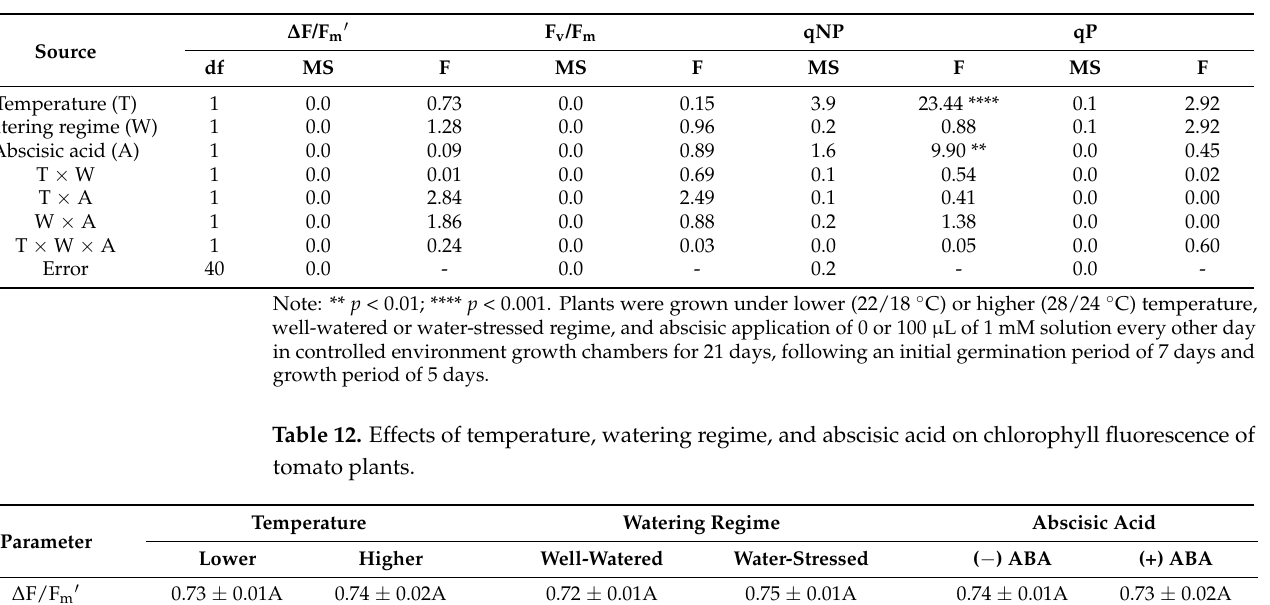
Table 11. Analysis of variance for effects of temperature, watering regime, abscisic acid, and their interactions on effective quantum yield of PSII ( ∆ F/F m (cid:48) ), maximum quantum yield of PSII (F v /F m ), non-photochemical quenching (qNP), and photochemical quenching (qP) of tomato plants.